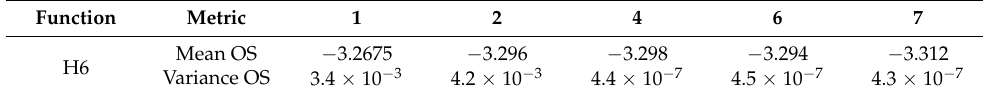
Table 7. Results of different NSP values in each iteration using the H6 function. Function